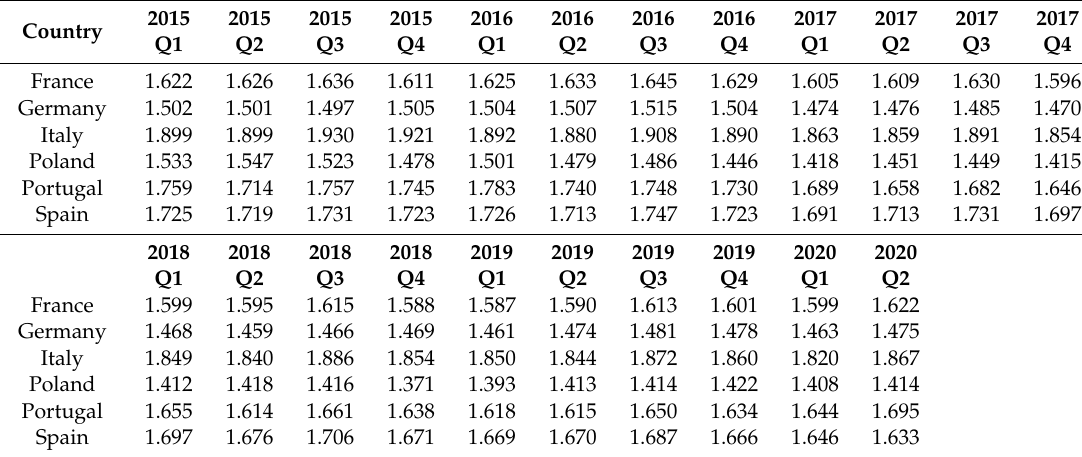
Table 5. Export multipliers, own work, source: